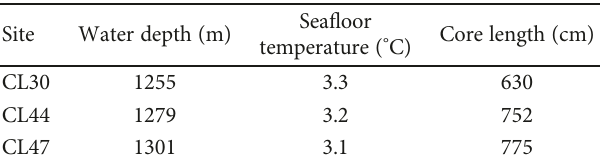
Figure 1: (a) Location of the study area. The grey area represents the subsurface area lineated by seismic investigation. The location of the reference core SO49-37KL (blue circle) is also shown. (b) Locations of sampling sites (red dots) and the Haima cold seeps (blue dots). Table 1: Information on the studied cores from the northwestern South China